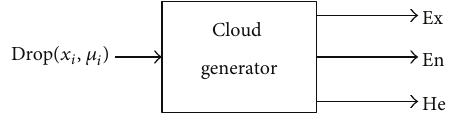
Figure 10: Back cloud generator.